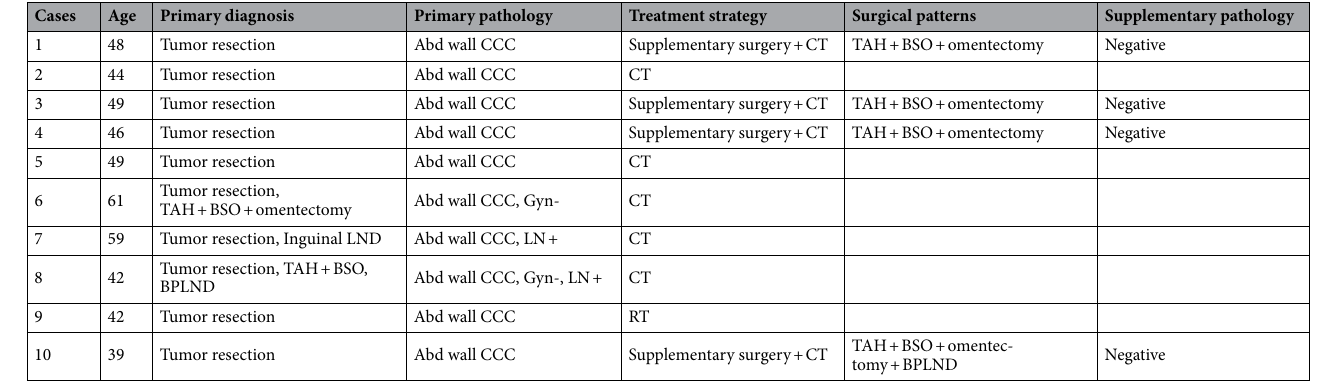
Table 1. Clinical and pathological outcomes of patients with clear cell carcinoma of the abdominal wall. CT chemotherapy, RT radiotherapy, TAH total abdominal hysterectomy, BSO bilateral salpingo-oophorectomy,